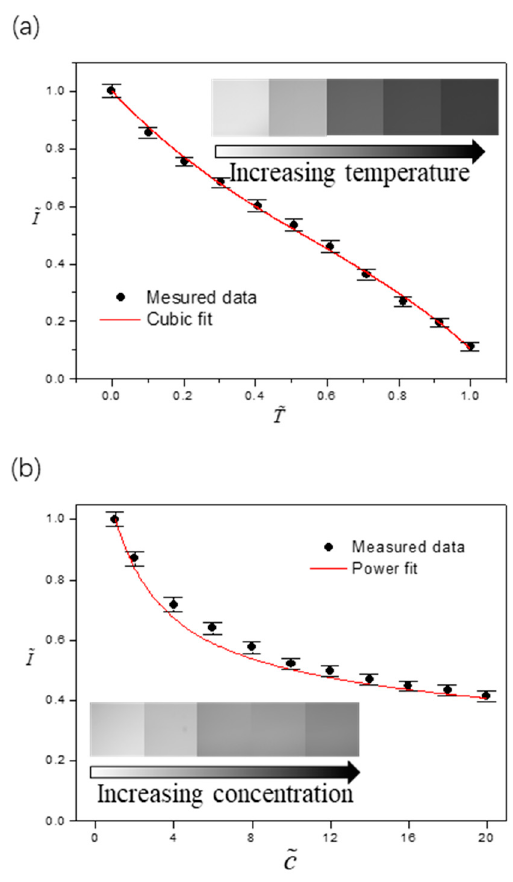
Figure 3. Characterized dependence of the fluorescence intensity on ( a ) temperature and on ( b ) con- centration of the fluorescence dye. The error bars were obtained from five independent measure- ments.